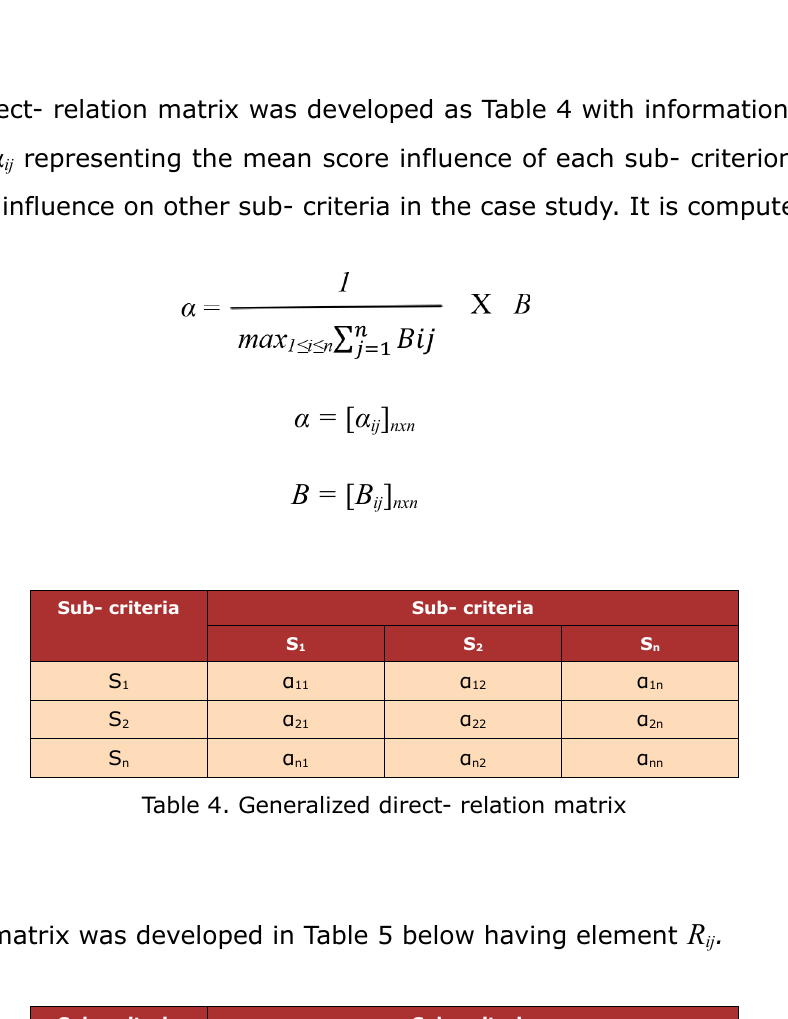
Table 3. Fuzzy linguistic scale for sustainability criteria